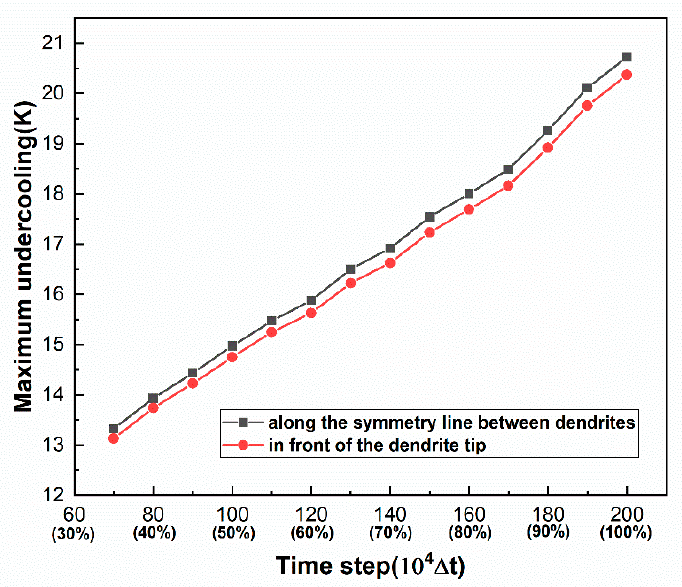
Figure 8. The comparison between the maximum undercooling along the symmetry line between columnar dendrites and the maximum undercooling ahead of dendrite tip.